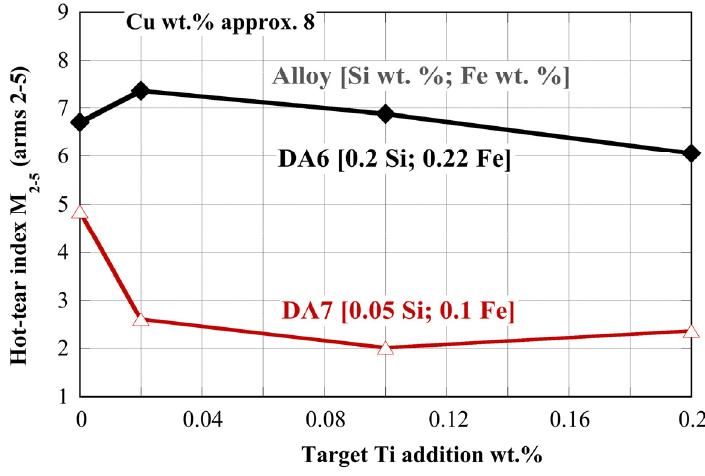
Figure 10. The HTI as a function of wt.% Ti addition for alloys DA6 and DA7 (Fe + Si effect).